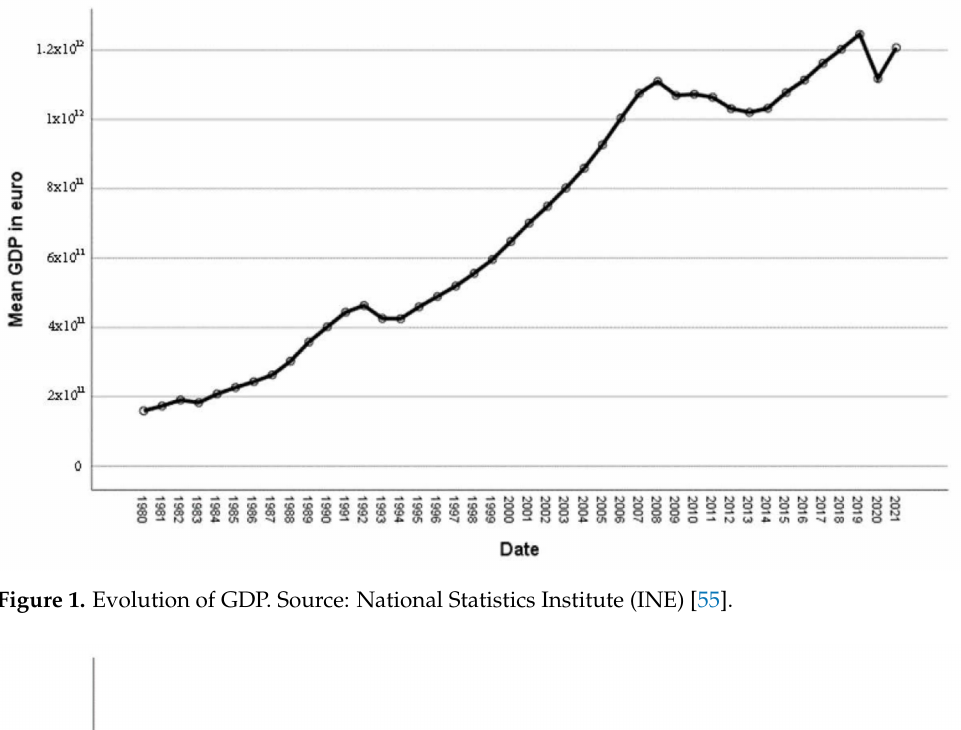
Figure 1. Evolution of GDP. Source: National Statistics Institute (INE) [55].